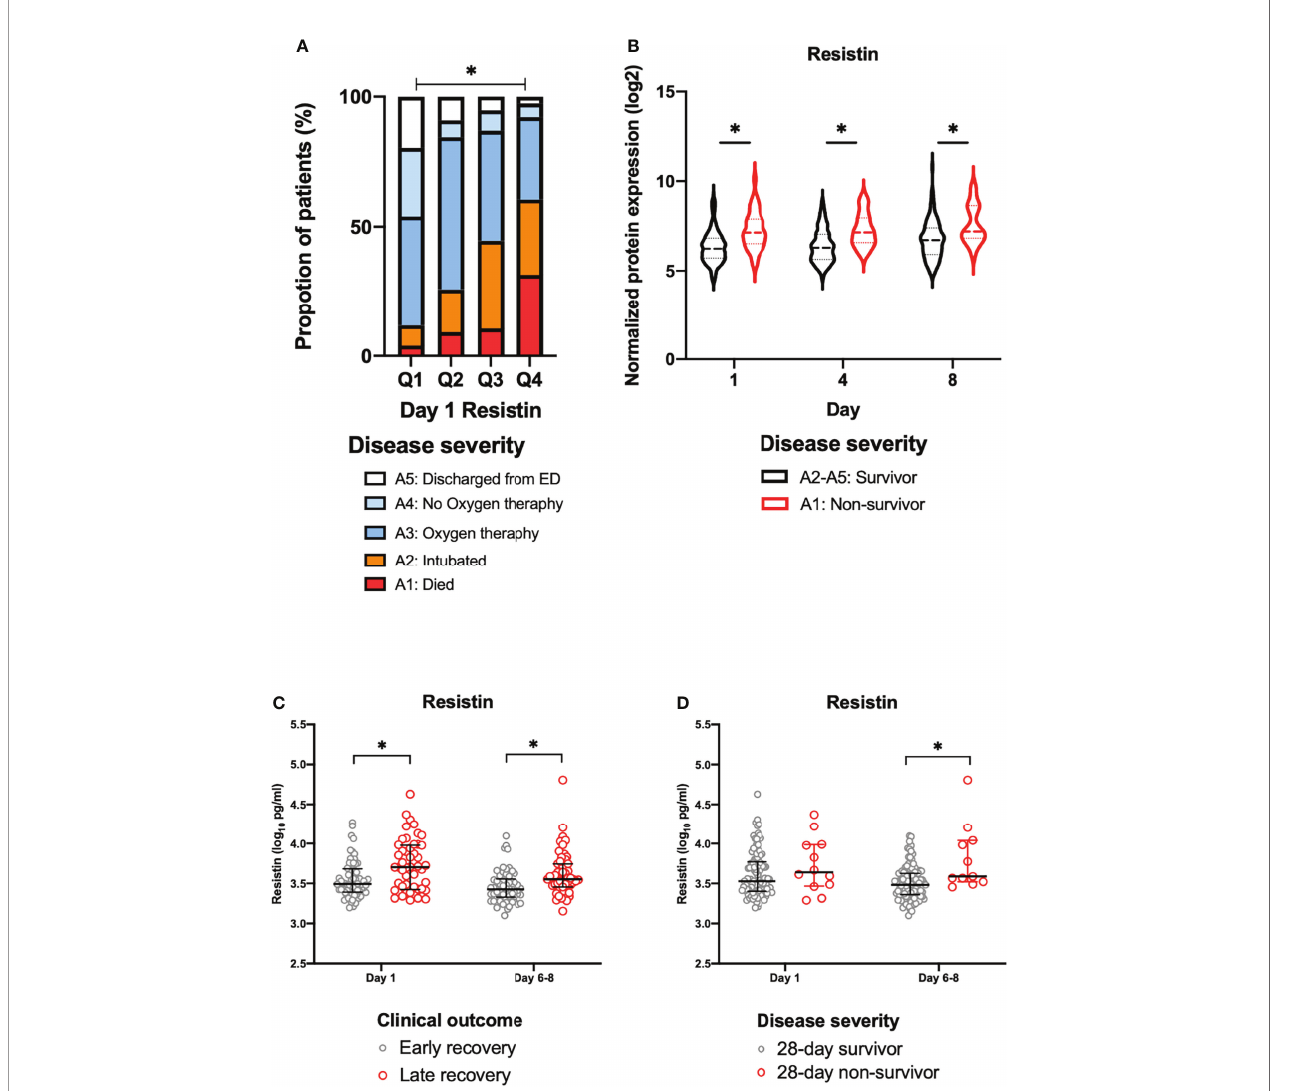
FIGURE 2 | The association between plasma resistin and disease severity or clinical outcome. (A) The disease severity by quartiles of day 1 resistin levels in the MGH cohort. Asterisk indicates a statistically signi fi cant difference between disease severity and the day 1 resistin levels. (B) Change in the normalized protein expression value of resistin in survivors (A2-A5) and non-survivors (A1) on days 1, 4 and 8 in the MGH cohort. Asterisk indicates a statistically signi fi cant difference between survivors (A2-A5) and non-survivors (A1) (P < 0.05) on each day. The resistin levels for early recovery and late recovery (C) and 28-day survivors and non- survivors (D) on each day in Osaka cohort 1. The error bars show the median and upper and lower quartiles. Asterisks indicate a statistically signi fi cant difference (P < 0.05) between two groups on each day by Wilcoxon rank sum test. ED, emergency department; MGH, Massachusetts General